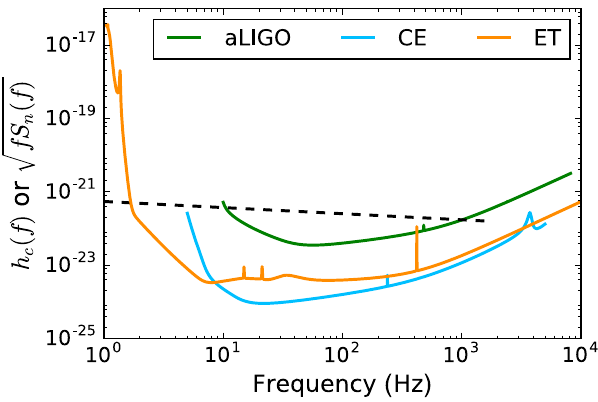
FIG. 6. Dimensionless noise spectral density aLIGO, CE, and ET GW detectors. The quantity S one-side design PSD [23,74,75]. The dashed line describes the (dimensionless) pattern-averaged characteristic strain h 2 f j ~ h ð f Þj for a BNS with rest-frame masses ð 1 . 25 M at 200 Mpc ( z ≃ 0 . 0438 ), up to the innermost-stable circular orbit given by Eq. (A3).